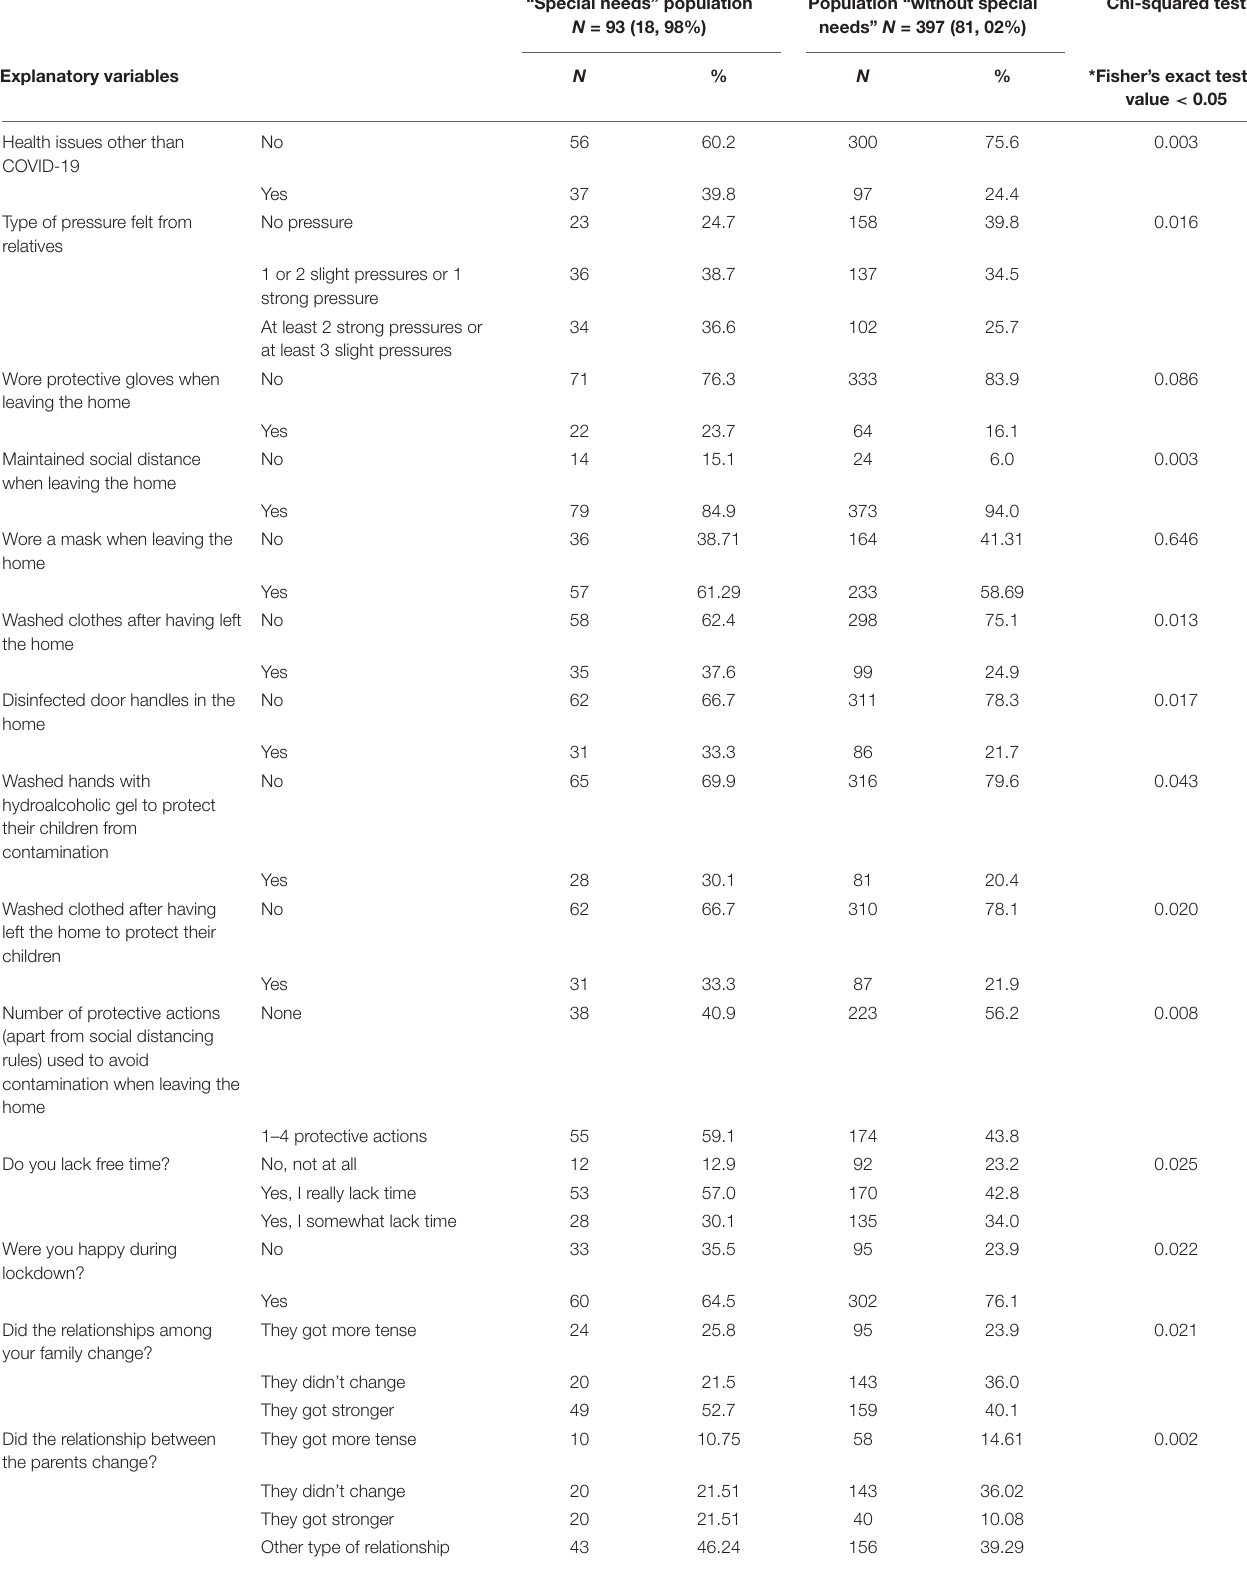
TABLE 3A | Experience of families with a child with special needs: bivariate analyses of “special needs” population vs. “population without special needs.”